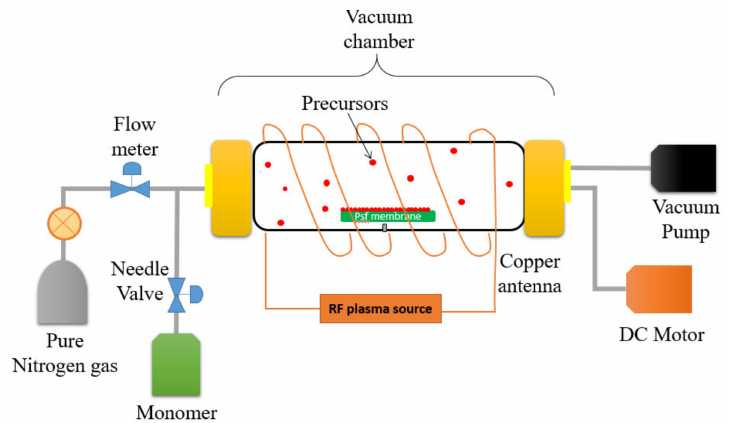
Figure 2. Illustration of the plasma-enhanced chemical vapor deposition (PECVD) process for surface modification of a polysulfone (PSf) flat sheet